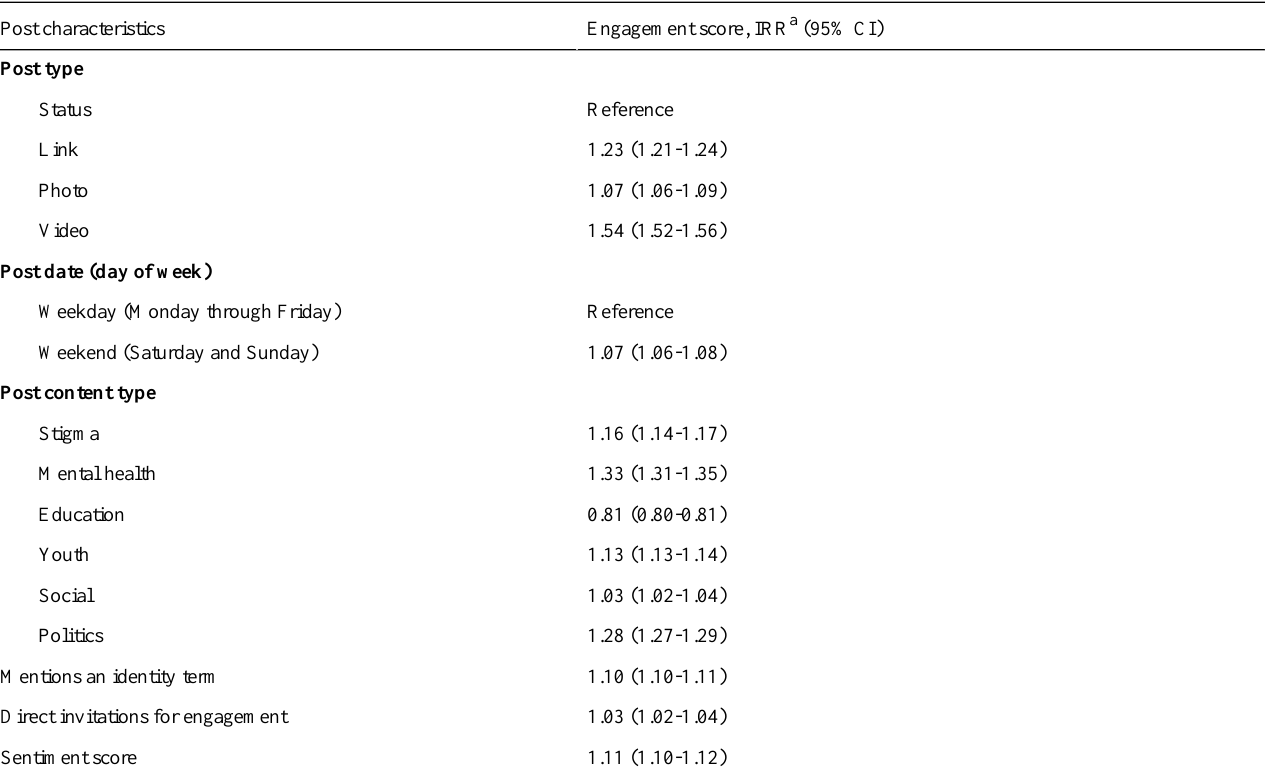
Table 3. Associations of post characteristics with user engagement with Facebook posts by lesbian, gay, bisexual, transgender, and queer community centers in the United States,